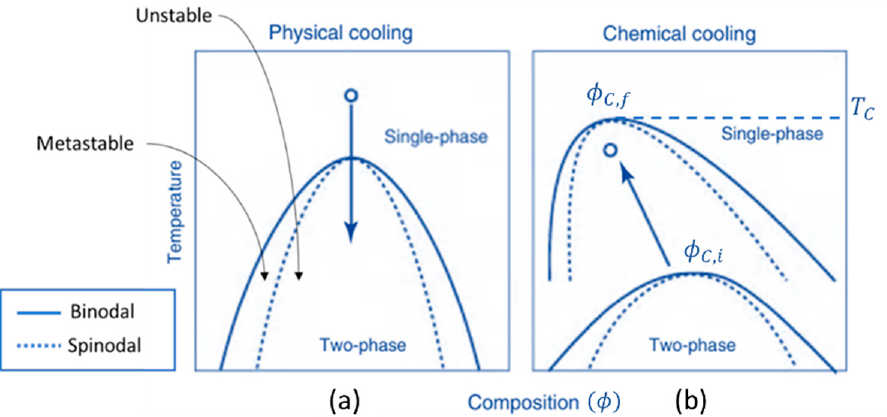
Figure 2. Illustrative phase diagrams of systems with immiscibility window for comparison of physical ( a ) and chemical ( b ) cooling phenomena. Chemical cooling extends the two-phase region by an increased chemical bond, to include the composition initially located in the single-phase region. Reprinted, with adaptations, by permission from Springer Nature Customer Service Centre GmbH: Springer, J. Sol-Gel Sci. Technology, Polymerization-induced phase separation in silica Sol-gel systems containing formamide, Kaji H, Nakanishi K, Soga N, © Kluwer Academic Publishers. Manufactured in The Netherlands (2013)